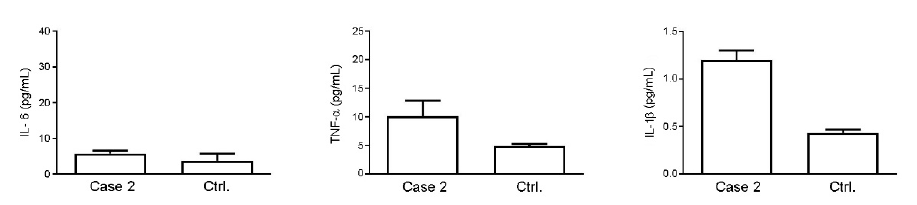
Figure 4. Analysis of levels of IL ‐ 6, TNF ‐α and IL ‐ 1 β in the serum of Case 2 compared to control donors. Values are expressed as pg/mL. donors. Values are expressed as